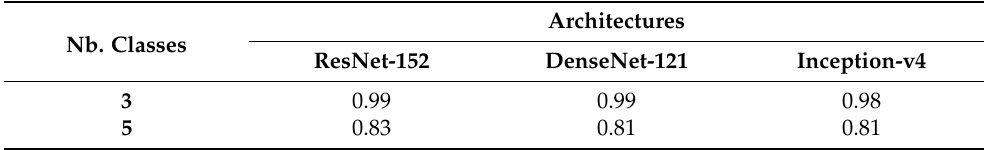
Table 5. Results of meteorological conditions classification into 3 and 5 classes with different architec- tures on the Cerema-AWH database.